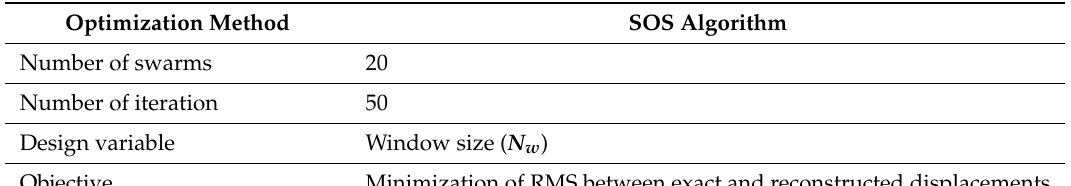
Table 2. Summary of metaheuristic optimization used in this study.